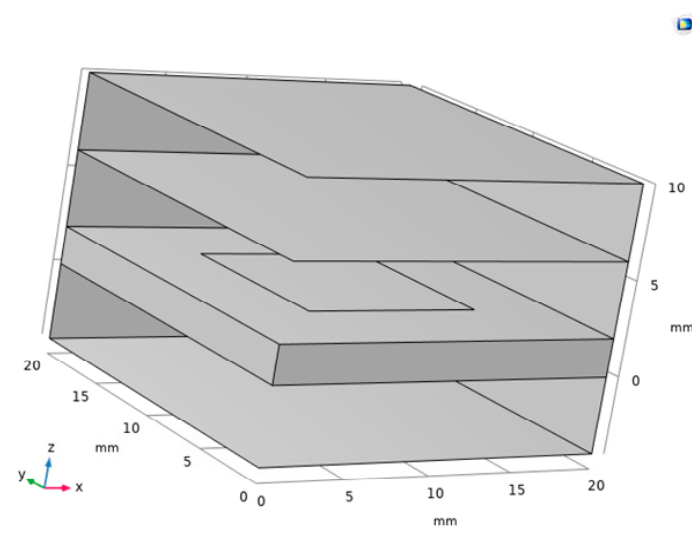
Figure 17. Graphene copper-clad electrode plate model.